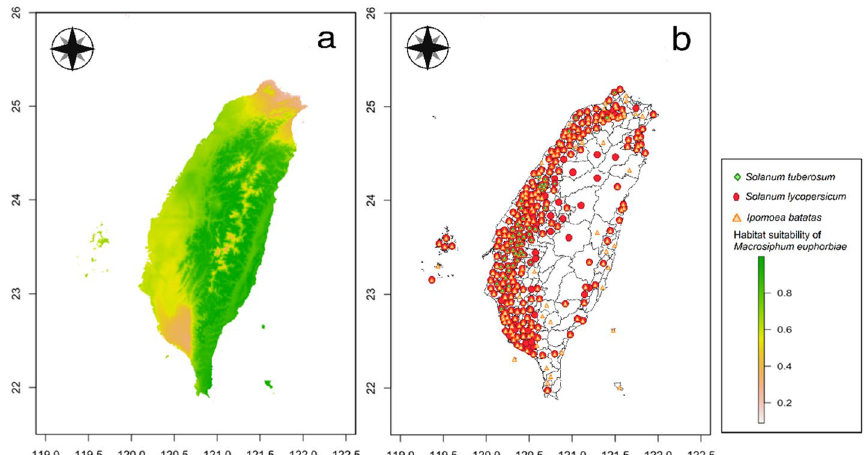
Figure 8. Comparison of potential distribution area of Macrosiphum euphorbiae and cultivation areas of Solanum tuberosum , S. lycopersicum , and Ipomoea batatas in Taiwan: ( a ) potential distribution ( b ) cultivation areas. Maps were created using R version 4.04 (https:// www.r- proje ct. org/) and QGIS version 3.12.1 (www. qgis. org).